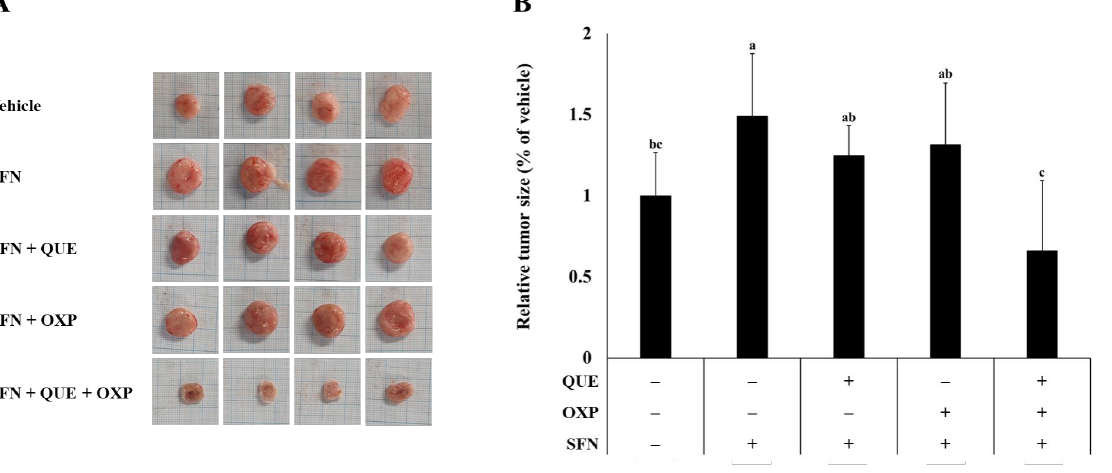
Figure 7. A combination of QUE, SFN, and OXP synergistically reduced the tumor size in HCT116 xenograft mouse model. ( A ) The xenograft tumors were dissected on the day of sacrifice. ( B ) The length and width of each tumor were measured using a caliper. Error bars represent mean ± SD ( n = 4). Different alphabetical letters indicate significant differences among the conditions ( p < 0.05, one-way ANOVA with Duncan’s post hoc HSD test).